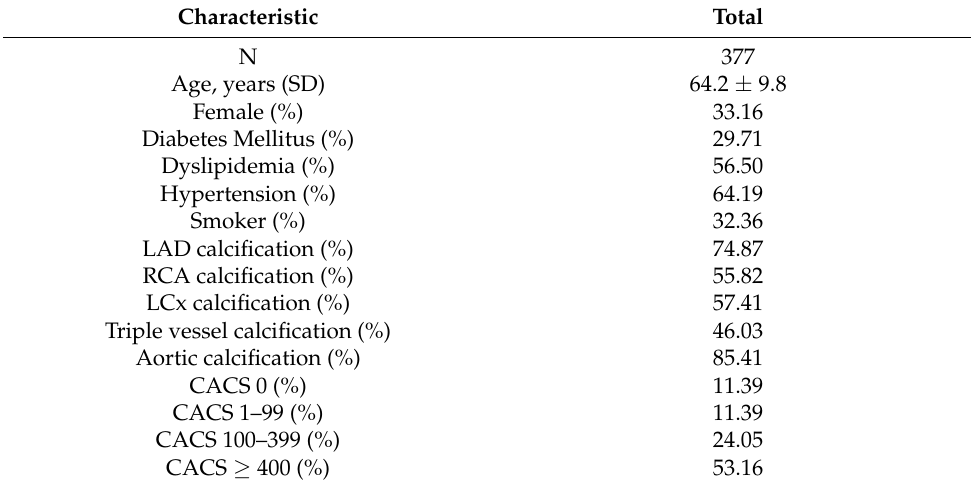
Table 1. Baseline